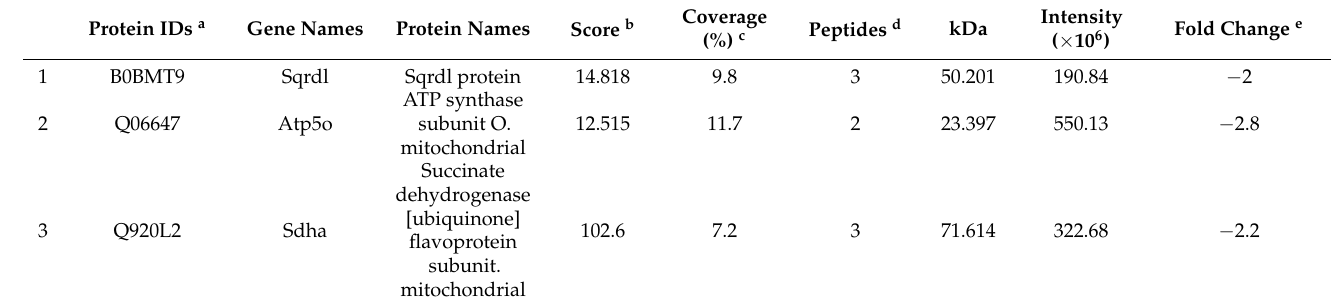
Table 5. nLC-MS identified HepG2 proteins that are found in control and EO-treated cells with differential